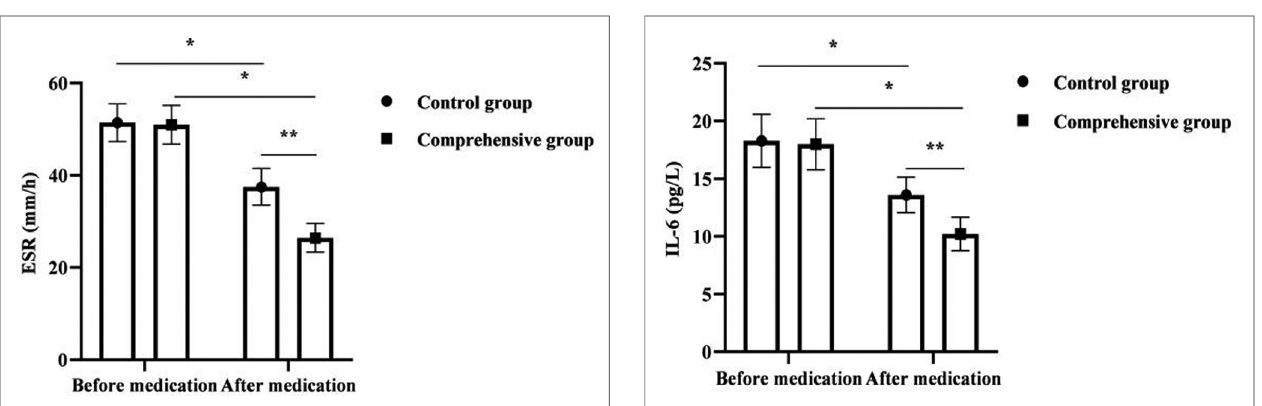
FIGURE 2 | Analysis of ESR, CRP and IL-6 levels in 120 children. Note: * was p <0.05 for the comparison before and after medication; ** was p <0.05 for the comparison after medication.